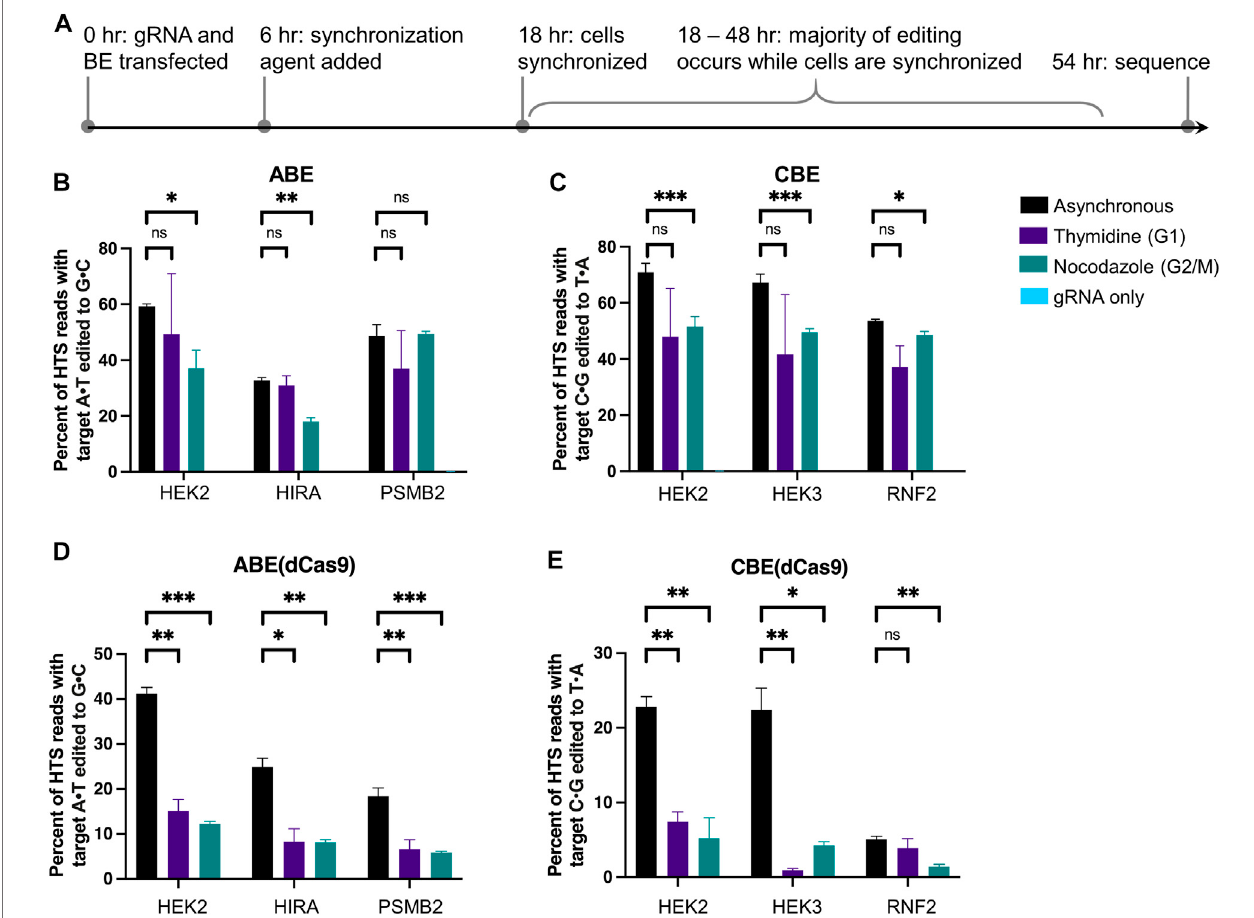
FIGURE 2 | Cell cycle synchronization effects on base editing ef fi ciencies and precision of ABE, ABE (dCas9), CBE, and CBE (dCas9) in HEK293T cells. (A) Cells were transfected with BE plus gRNA (protospacer sequences indicated in Figure 1 ), synchronization agents were added 6 h post-transfection (thymidine for G1 synchronization ornocodazole forG2/Msynchronization),and cellswerelysed at54 h. Asanegativecontrol,cellsweretransfectedwithgRNA plasmid only(gRNAonly sample).ThegenomicDNAwasextracted,andtargetlociwereampli fi ed via PCRandsubjectedtohigh-throughputsequencing(HTS).Genomeeditingef fi ciencies (cid:129) (cid:129) (cid:129) [percent of total HTS reads with the target A T base converted to G C for ABE and ABE (dCas9), or percent of total HTS reads with the target C G base converted to (cid:129) T A for CBE and CBE (dCas9)] were quanti fi ed with CRISPResso2. Base editing ef fi ciencies by ABE (B) , CBE (C) , ABE (dCas9) (D) , and CBE (dCas9) (E) are plotted. Values and error bars re fl ect the means and SD of three independent biological replicates performed on different days. Asterisks re fl ect p value calculations of unpaired t test, one tailed (ns indicates not signi fi cant, * p < 0.05, ** p < 0.01, *** p < 0.001).